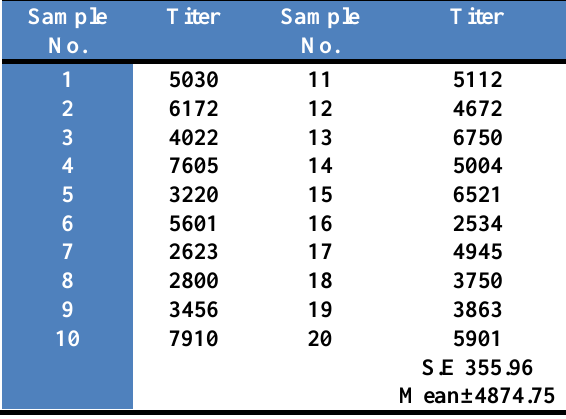
Table, 1: Detection of ILT virus antibodies by ELISA test for infected group 12 days post